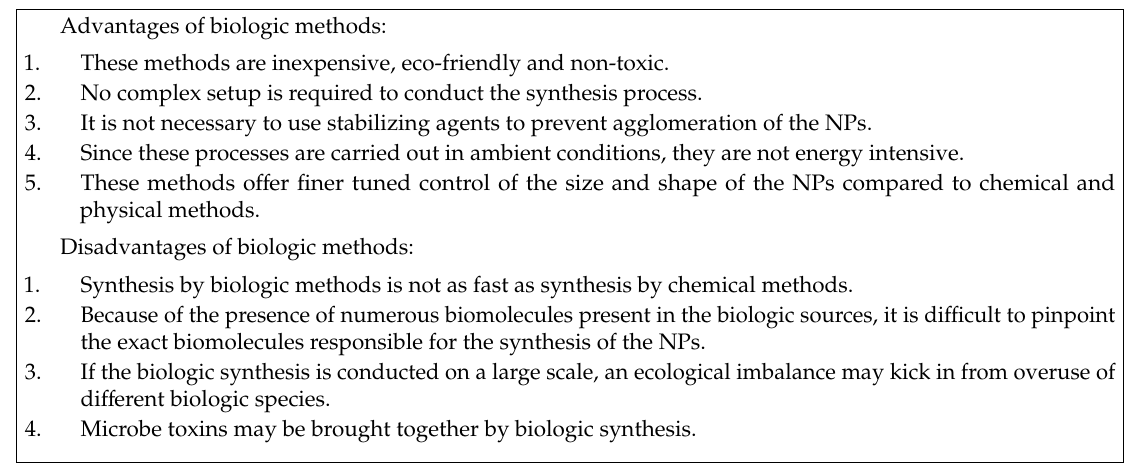
Table S1: Studies AgNPs from Bacteria, Fungi, and Algae that inhibit di ff erent cancer cell